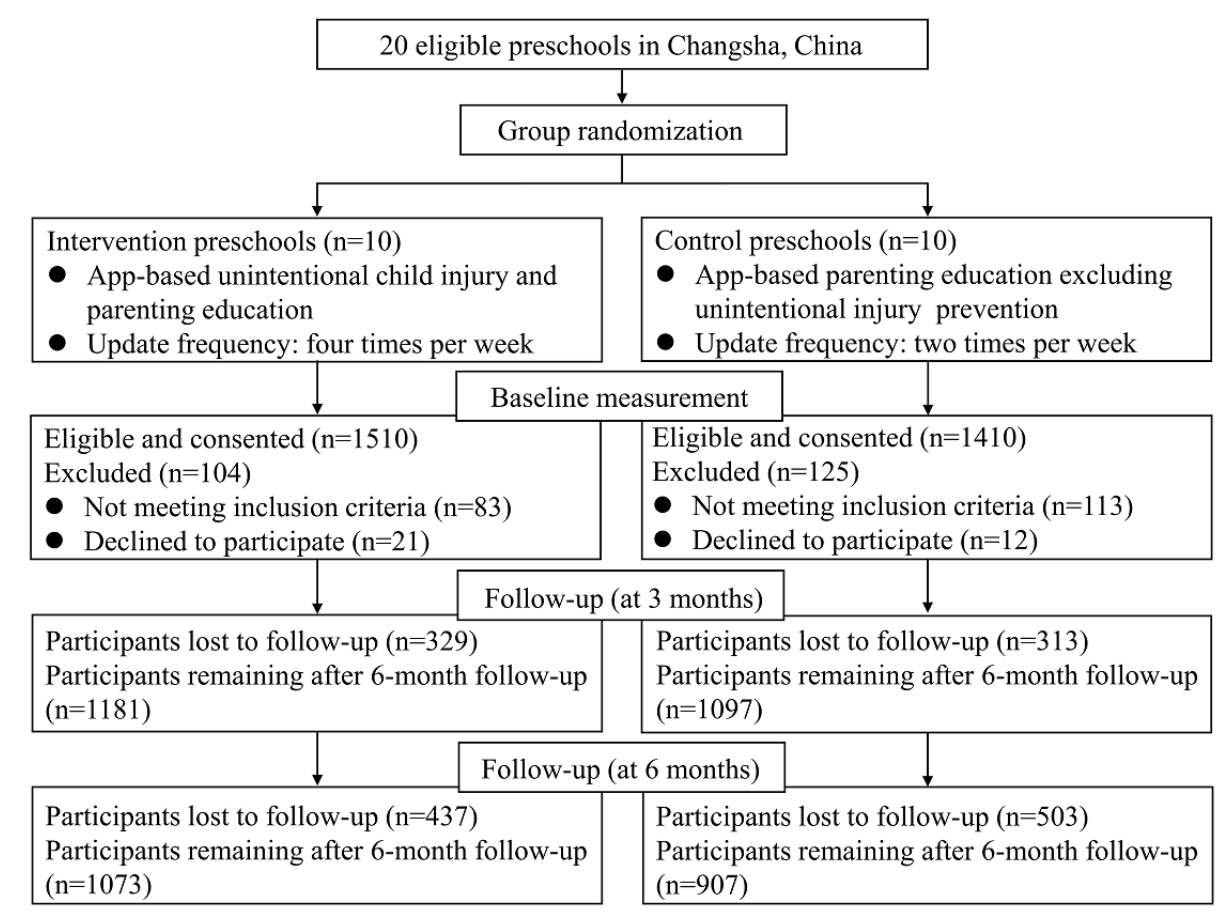
Figure 1. Flow diagram of the app-based intervention